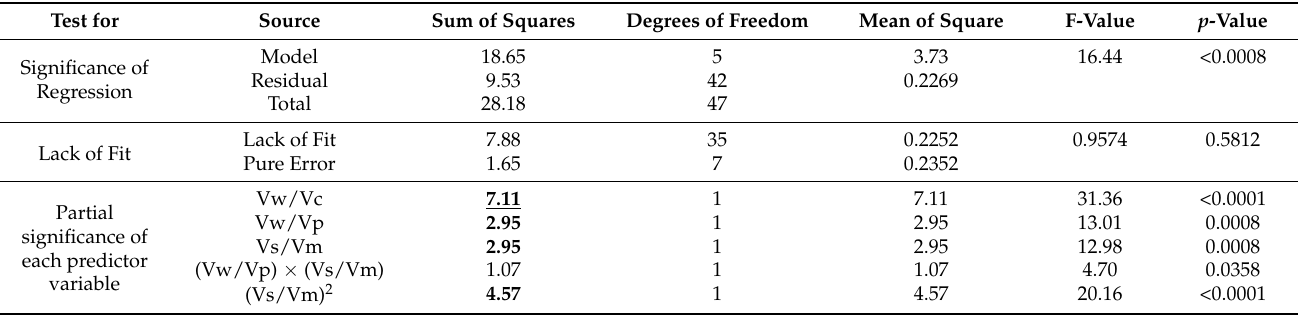
Table 9. ANOVA results for the F,24 h